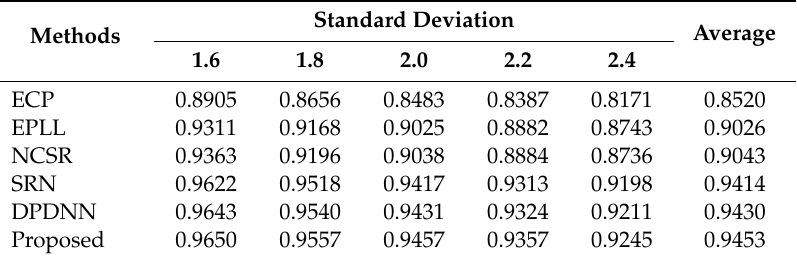
Table 2. The SSIM results of the deblurred images for all evaluated methods.